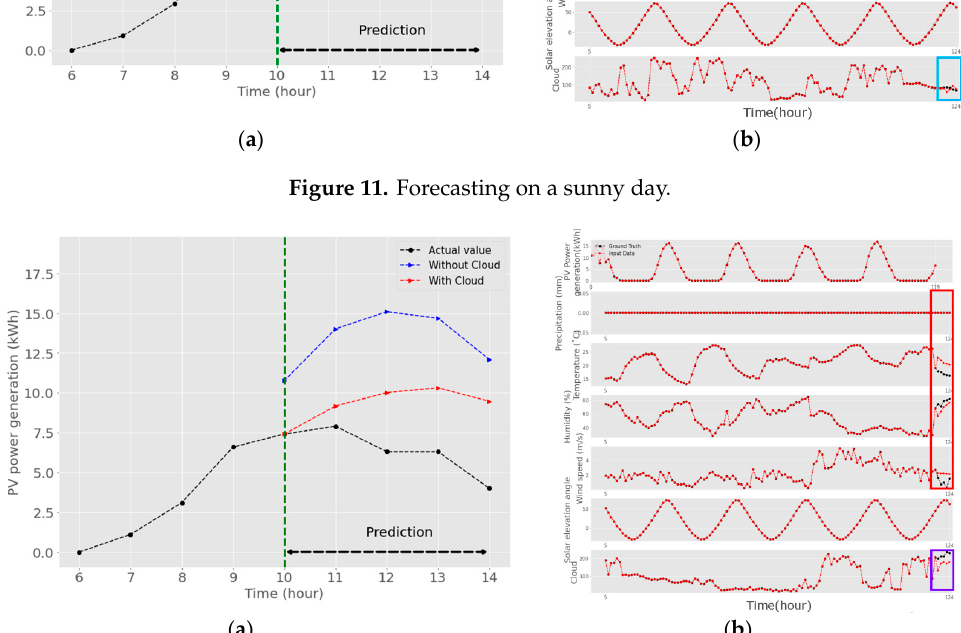
Figure 12. Forecasting on a cloudy day.